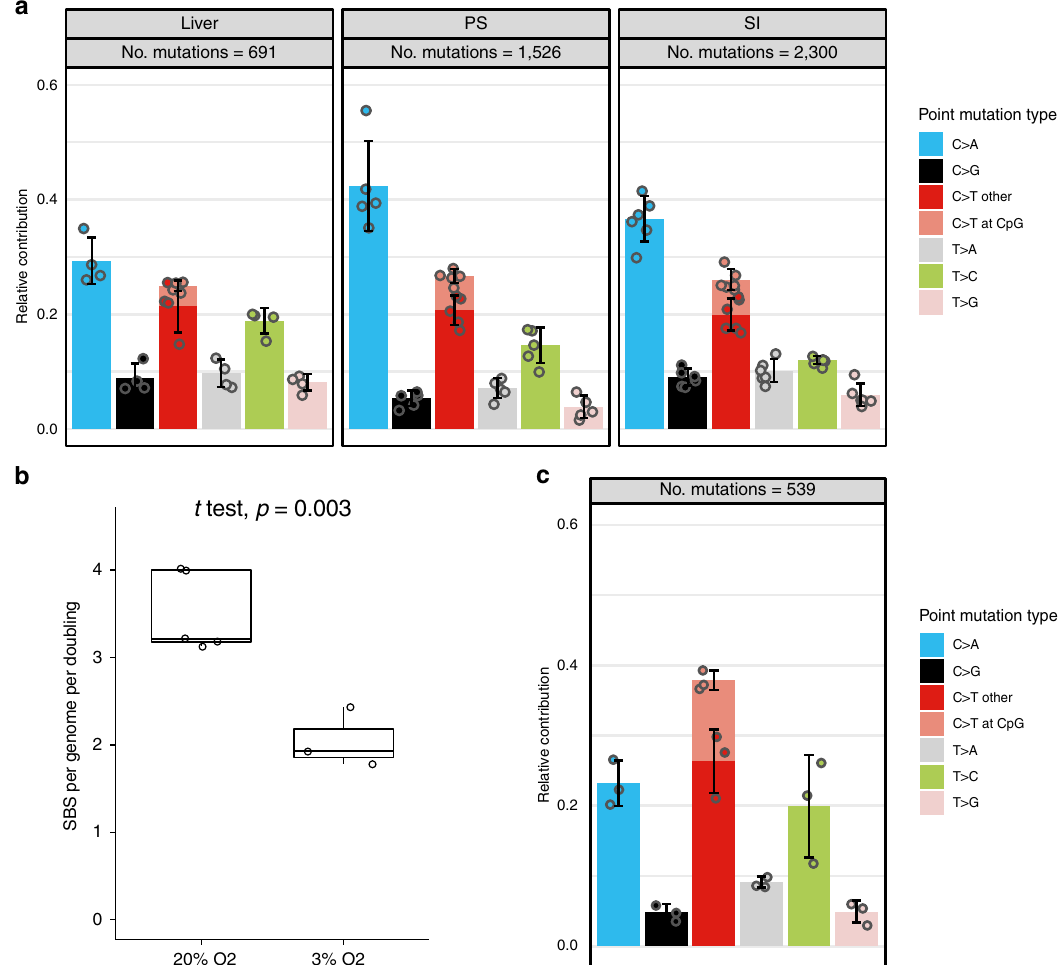
Fig. 2 Mutational spectrum and signature analysis. Data are derived from biological replicates. a Relative contribution of the indicated base substitution types to the mutation spectrum. Per stem cell type, data are represented as the mean relative contribution of each mutation type over all subclones (liver n = 4, PSC n = 5, and SI ASC n = 6). Error bars represent the standard deviation from the mean. The total number of SBS is indicated. b Box – whisker plots showing the median, fi rst and third quartiles, and minimum and maximum of the number of mutations per genome per population doubling under 20% and 3% O 2 . Statistical test used: two-sided t test. c Relative contribution of the indicated base substitution types to the mutation spectrum of individual human pluripotent stem cell lines ( n = 3) cultured for 3 months under 3% oxygen levels. Data are represented as the mean relative contribution of each mutation type over all subclones. Error bars represent the standard deviation from the mean. The total number of SBS is